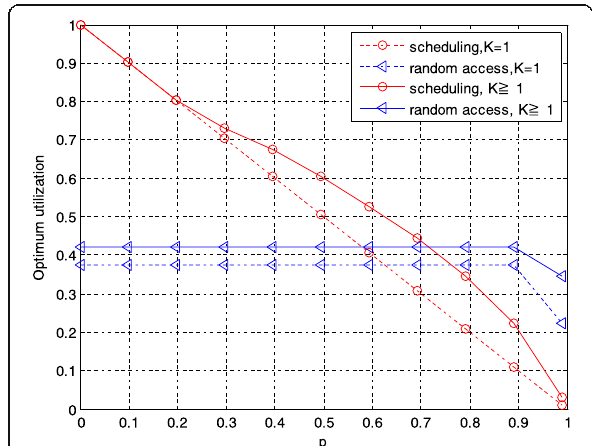
Fig. 8 Optimum utilization for MSS under scheduling-based and ran- dom access